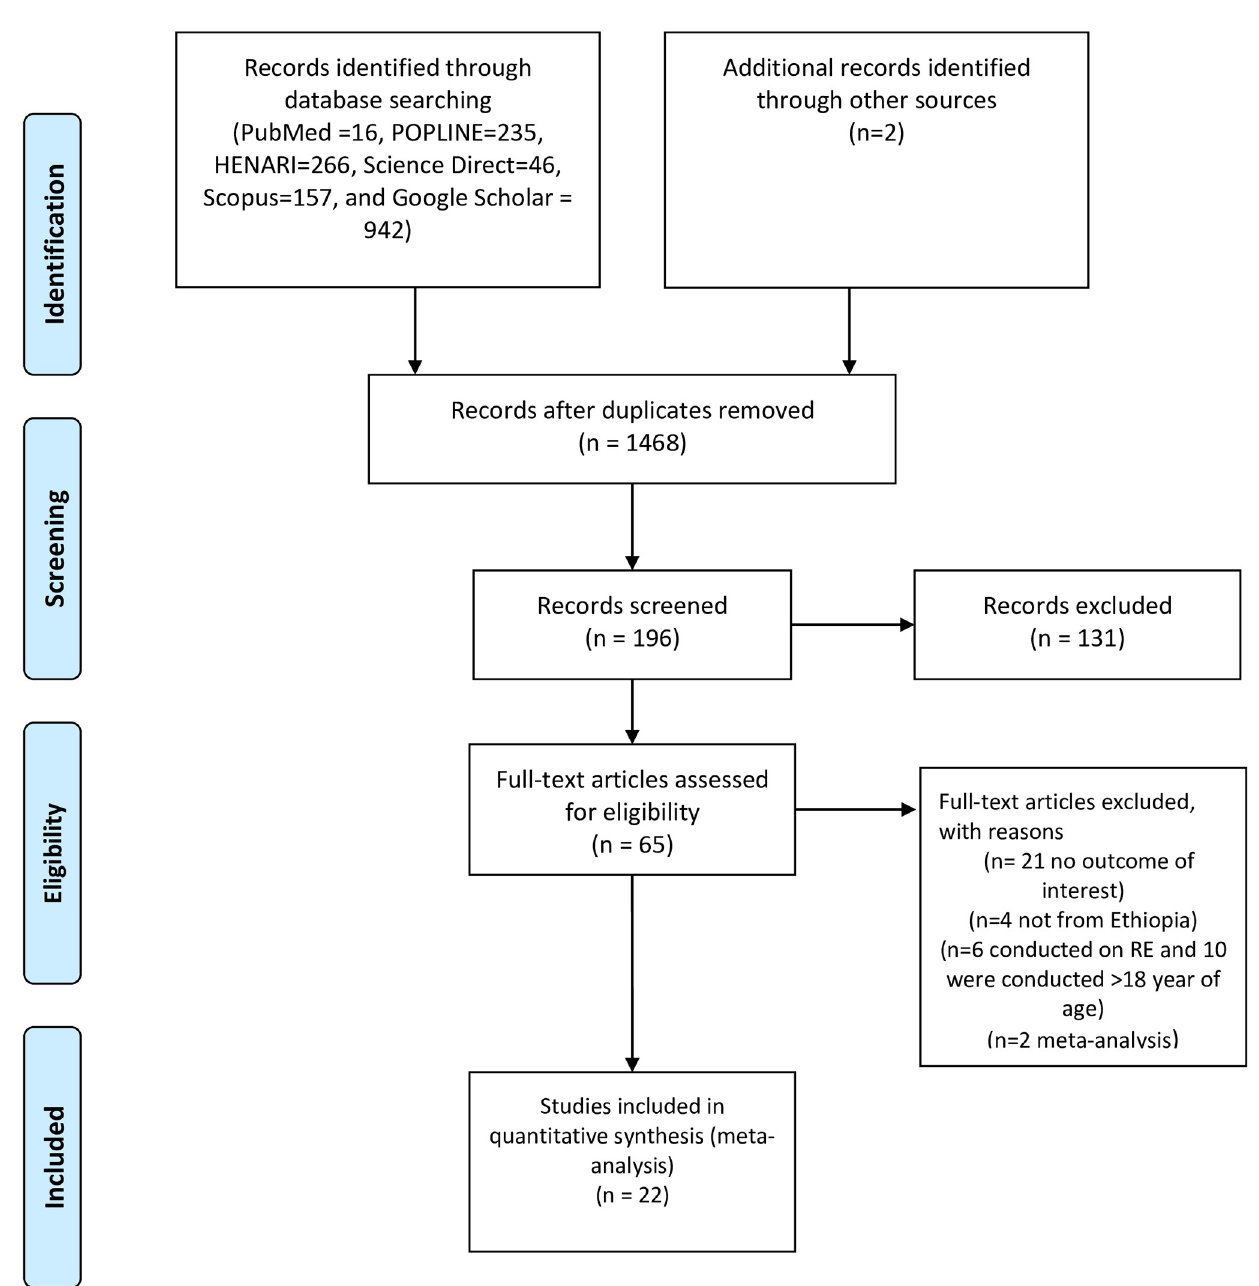
Fig 1. Flow diagram of systemic review and meta-analysis conducted on visual impairment due to refractive error in Ethiopia, 2021.